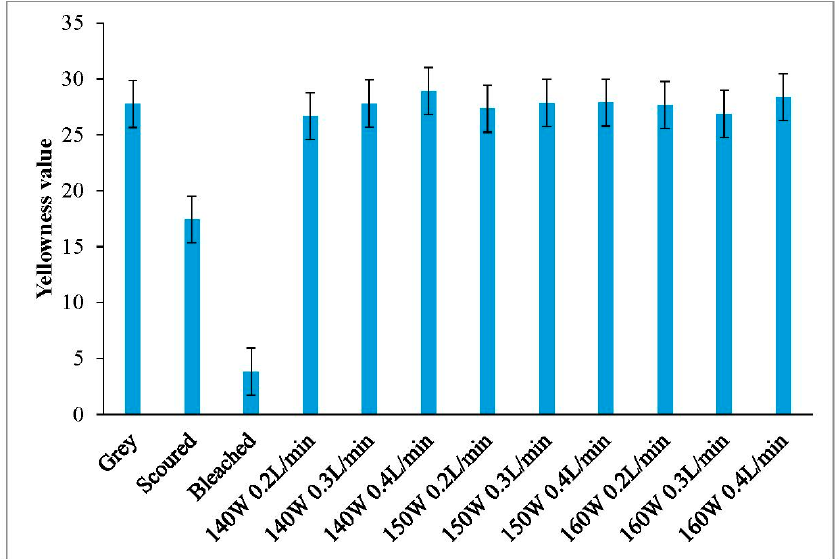
Figure 7. Yellowness values of single jersey fabric.